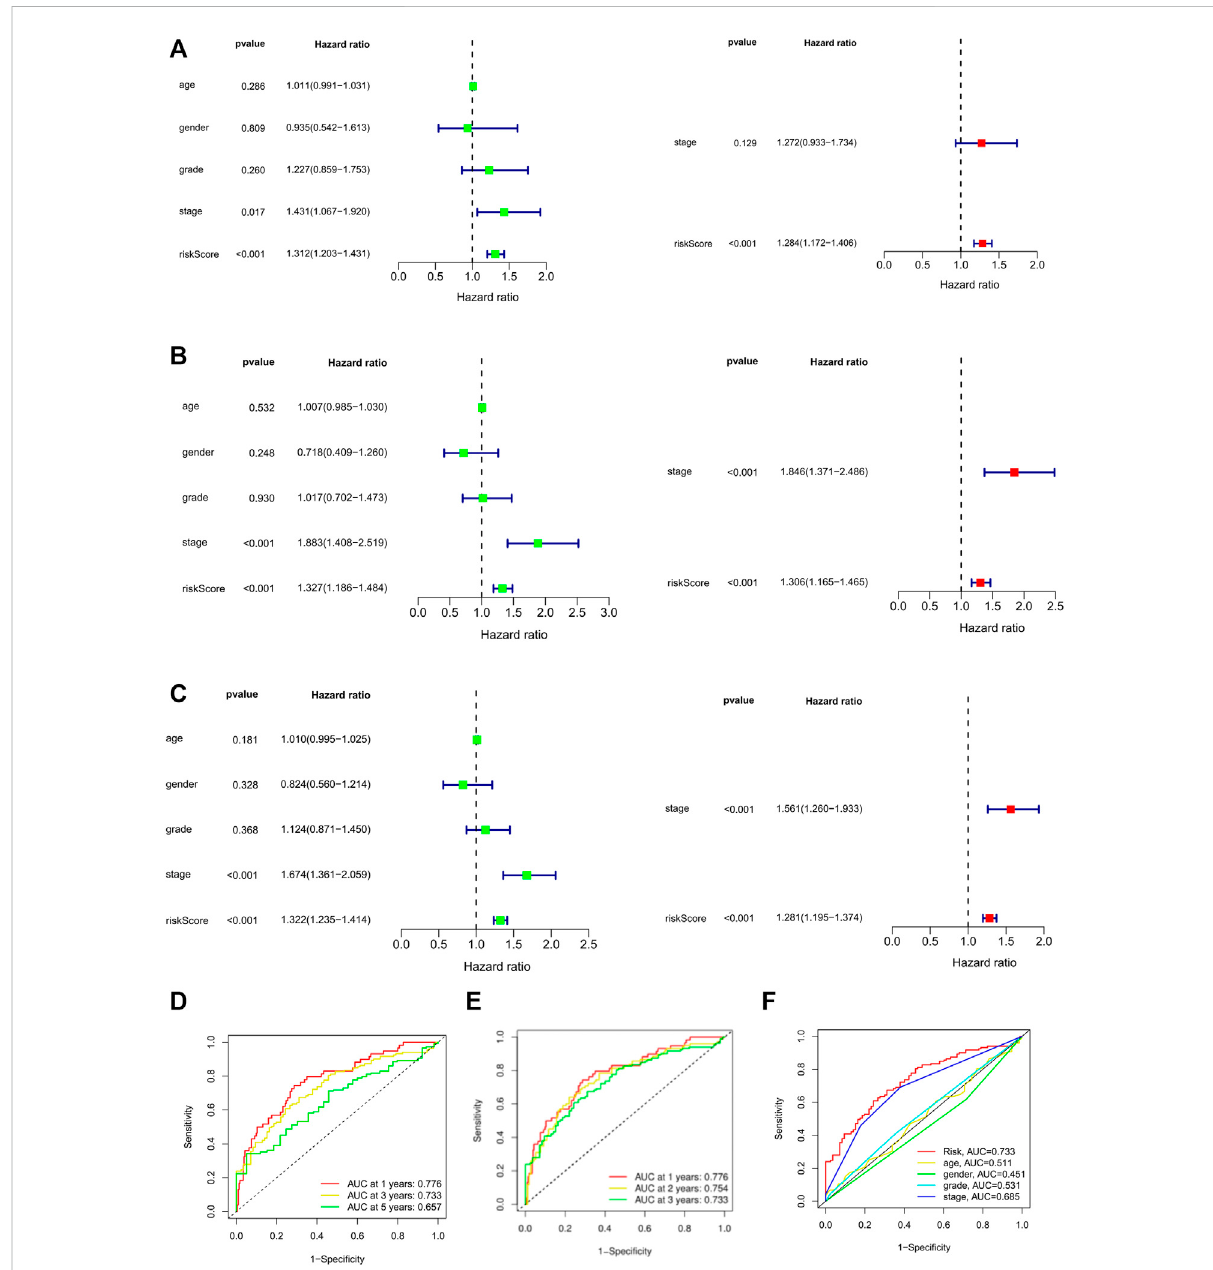
FIGURE 5 Univariate and multivariate Cox regression model for prognostic risk. (A – C) The univariate and multivariate Cox analysis of patients OS-related risksinTCGAtraining cohort, internalvalidationcohort,andwholecohort. (D) ROC curves of1,3, and5 yearsbasedon the10PRlncRNAssignatures in the whole cohort. (E) ROC curves of 1, 2, and 3 years based on the 10 PRlncRNAs signatures in the TCGA whole cohort. (F) ROC curves using multiscale features. OS: overall